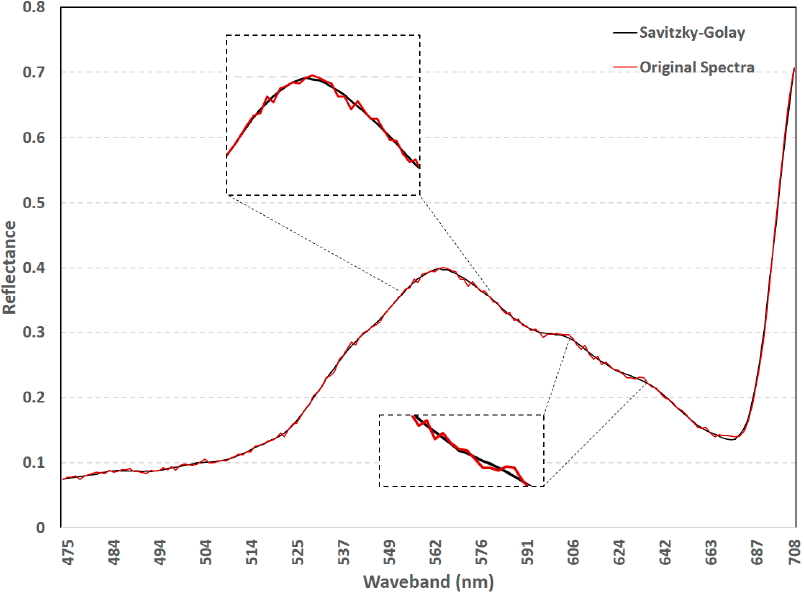
Figure 4. Spectra comparison before (red) and after (black) applying Savitzky-Golay filter.